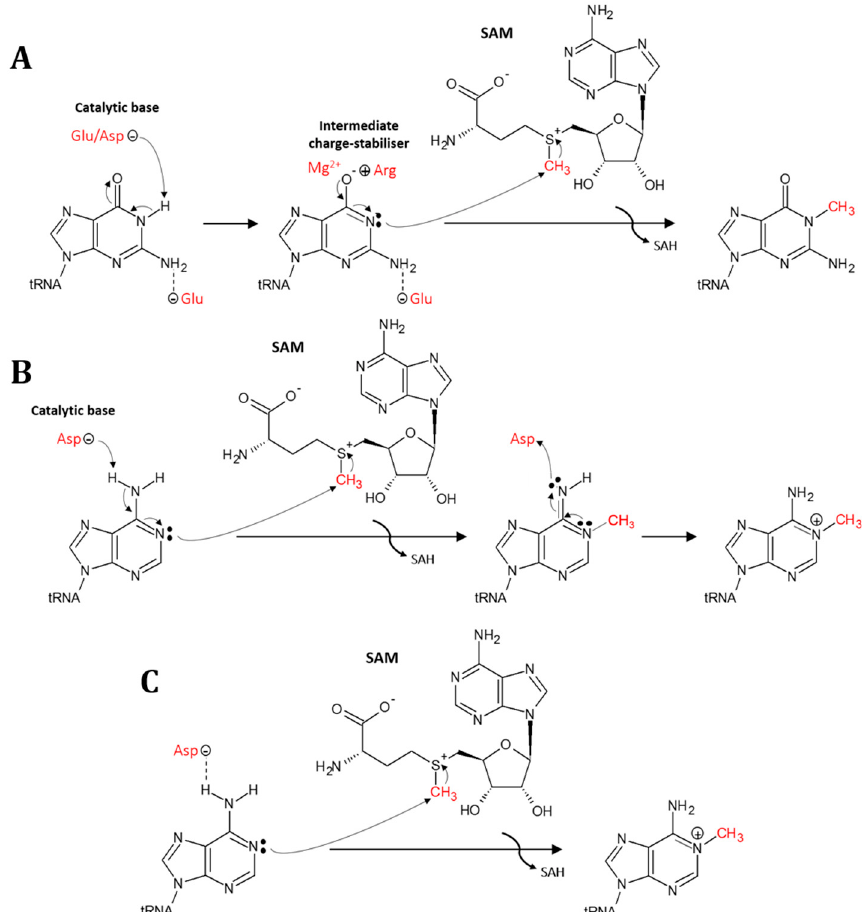
Figure 4. Mechanism for N1 ‐ methylation on purine bases using the cofactor S ‐ adenosyl ‐ L ‐ methionine (SAM) converting it to S ‐ adenosyl ‐ L ‐ homocysteine (SAH). ( A ) Mechanism for m 1 G37 formation by TrmD (with aspartate as catalytic base) or Trm5 (with glutamate as catalytic base). Only the guanine base of tRNA is depicted for clarity. ( B ) Suggested mechanism for m 1 A based on studies on TrmI (m 1 A58) with aspartate as the catalytic base. ( C ) Alternative mechanism for m 1 A based on studies on TrmI (m 1 A58) where aspartate serves merely to position the cofactor and methylation site for reaction. Due to the differences in protonation states of the N1 atom at physiological pH, the formation of m 1 A must proceed via a mechanism different from m 1 G. Two mechanisms for formation of m 1